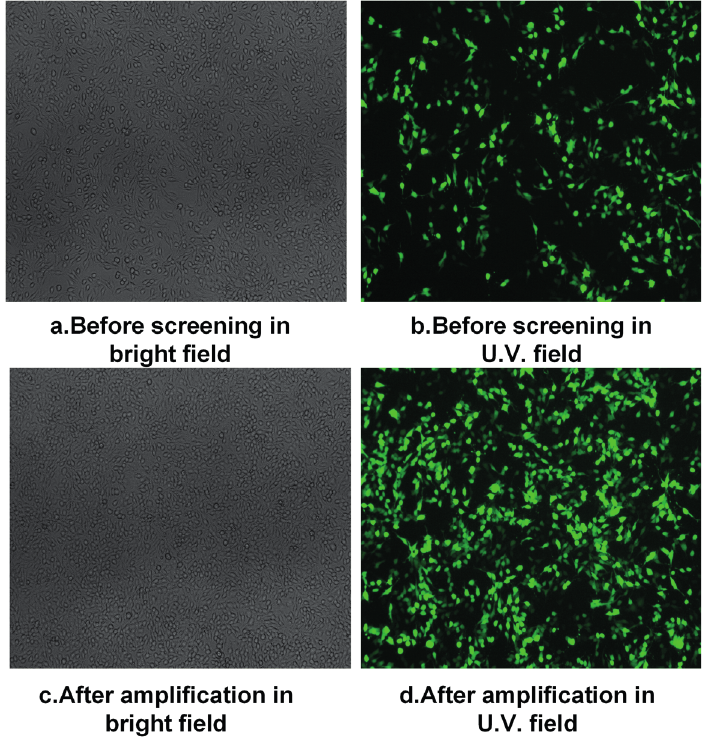
Figure 2 - Panels a and b show the HepG2.2.15 cells cultured with Hsa- miR-122 viral solution before screening. c and d show that the number of HepG2.2.15 cells increased after screening with puromycin.